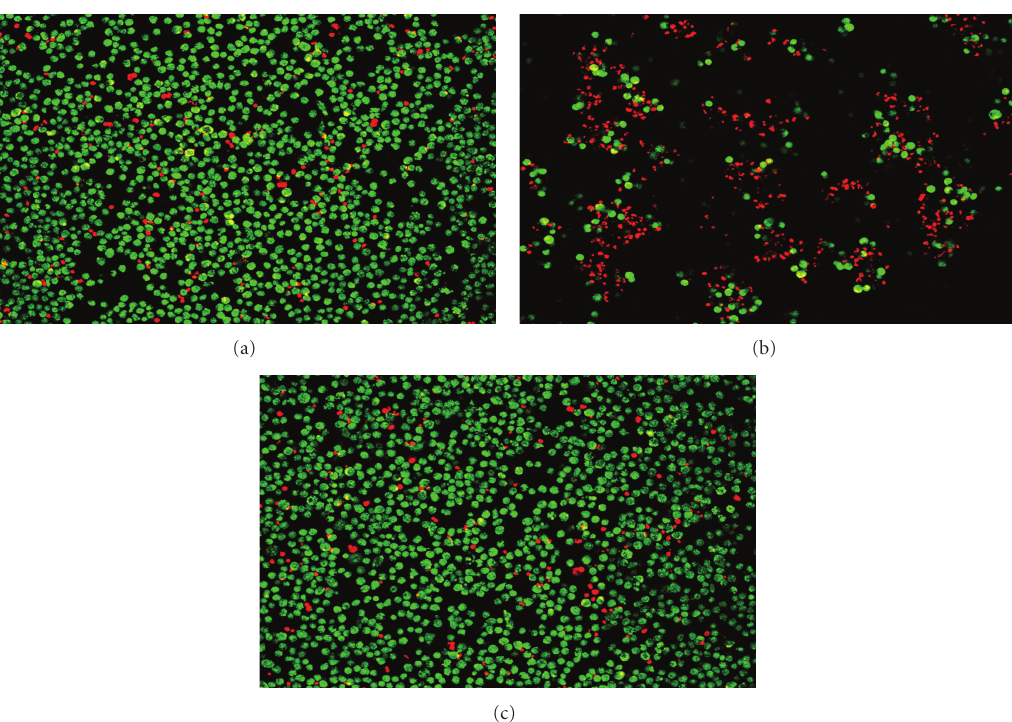
Figure 2: The cytoxicity of Y. pestis V antigen expressed from Y. pseudotuberculosis for J774 cells was inhibited by pretreatment with anti-V Mab 7.3. Cells were stained with ethidium bromide/acridine orange to identify live cells (green) and dead cells (red). (a) Unifected J774 cells, (b) J774 cells infected with Y. pseudotuberculosis expressing V antigen were killed, shown by the preponderance of dead cells. (c) J774 cells pretreated with Mab 7.3 prior to exposure to Y. pseudotuberculosis expressing V antigen were protected, with no significant di ff erence in appearance, compared with uninfected